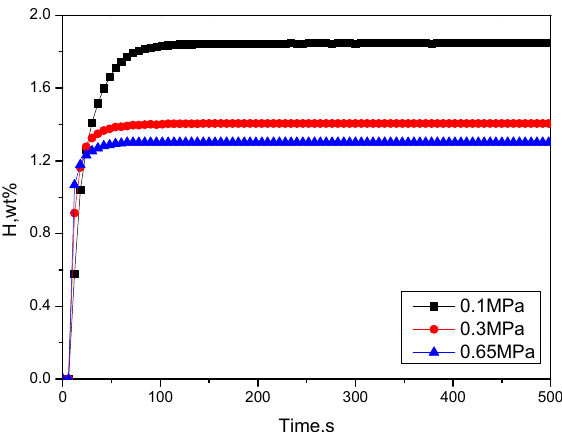
Figure 5. Hydrogen absorption kinetics curves at room temperature and different pressures after activating Zr 2 Fe at 400 °C for 3 h.